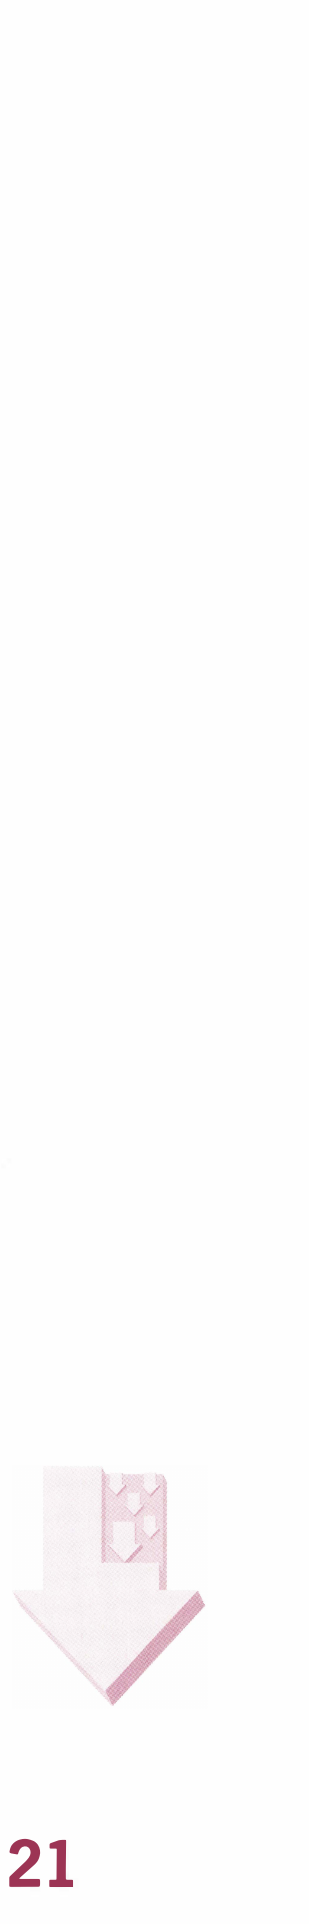
Fig. 7: Height of the fluid film h between the cylinder and piston, and the ratio of the loss due to viscous force F 1 to the applied weight Fo as a function of piston displacement. A newtonian fluid and the LOPE melt I are shown. H = height of the piston (DIN)